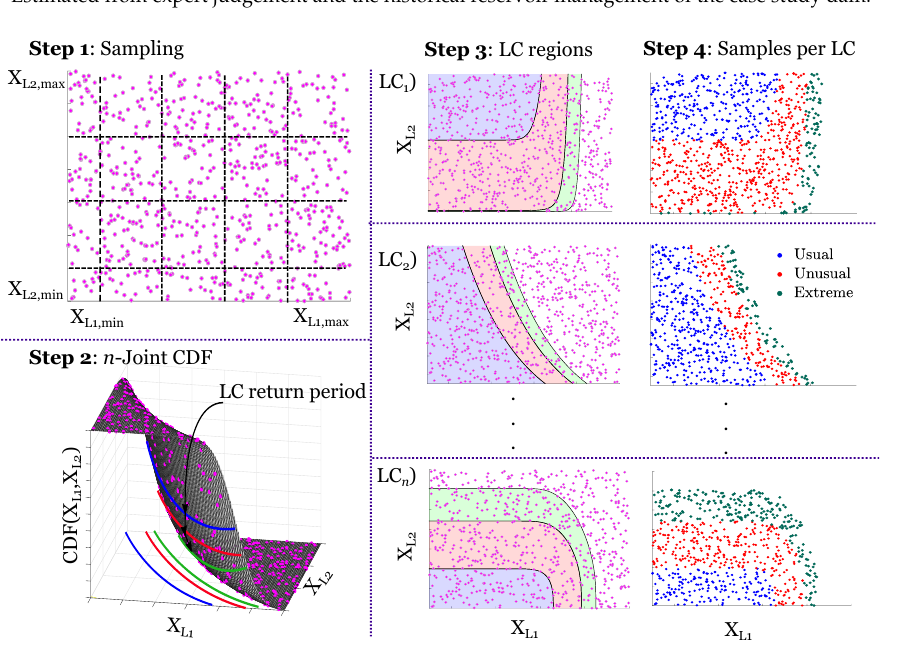
Figure 8. Procedure for obtaining samples per